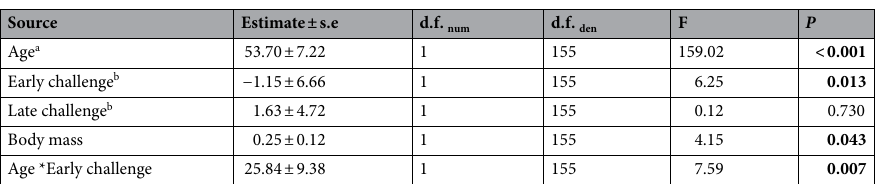
Table 1. Mixed linear model investigating variance in female egg production as a function of their age, their experience of an immune challenge occurring early or late in life and body mass measured before each reproductive episode. Female identity was included as a random factor. Values with P ≤ 0.05 are given in bold. This analysis was done on data from females that reproduced both early and late in life. a Comparison of young females relative to old females, which are used as the reference category (estimate = 0). b Comparison of control females relative to challenged females, which are used as the reference category (estimate =